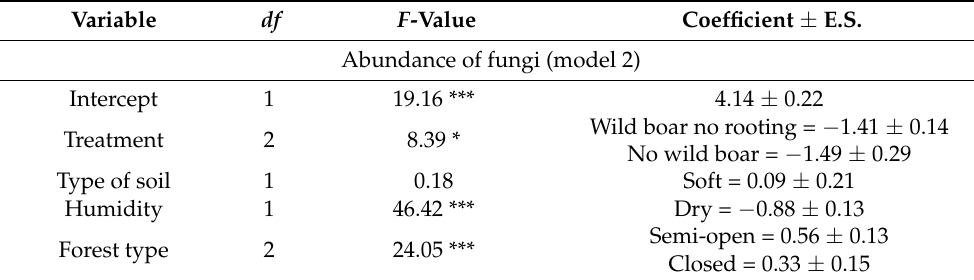
Table 2. Overall abundance (model 2) of fungal sporocarps, as responses to the presence of wild boar and wild boar rooting (three treatments), analyzed with GzLM. Coefficients for the level of fixed factors were calculated using reference values of the treatment ‘wild boar’ (with rooting) in the variable “treatment”, ‘rocky’ in the variable “type of soil”, ‘open’ in the variable “environmental type” and ‘wet’ in the variable “soil humidity”. (* p < 0.05; *** p < 0.001).